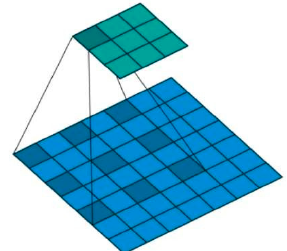
Figure 6. Dilated convolution schematic.